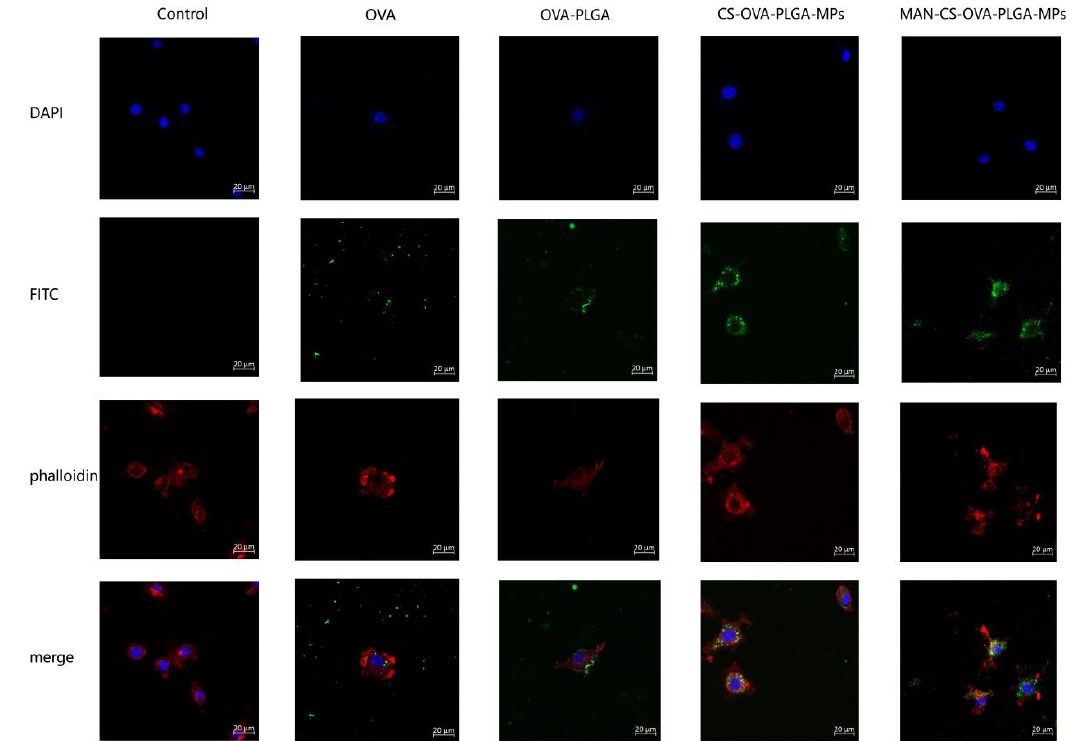
Figure 5. Laser confocal scanning microscopy analysis of MAN-CS-OVA-PLGA-MP uptake by DCs. DCs were inoculated in a 6-well cell-culture plate on a round coverslip. After 24 h of culture, OVA-PLGA, CS-OVA-PLGA-MPs, MAN-CS-OVA-PLGA-MPs, or OVA was added separately. After an additional incubation for 12 h, the cells on the coverslips were fixed and stained using DAPI and Phalloidin-iFluor 555. Blue fluorescence indicates the nucleus, labeled by DAPI, while red fluorescence indicates the actin, stained with Phalloidin-iFluor 555. Cells were mounted with 90% glycerol and visualized using a confocal laser scanning microscope.